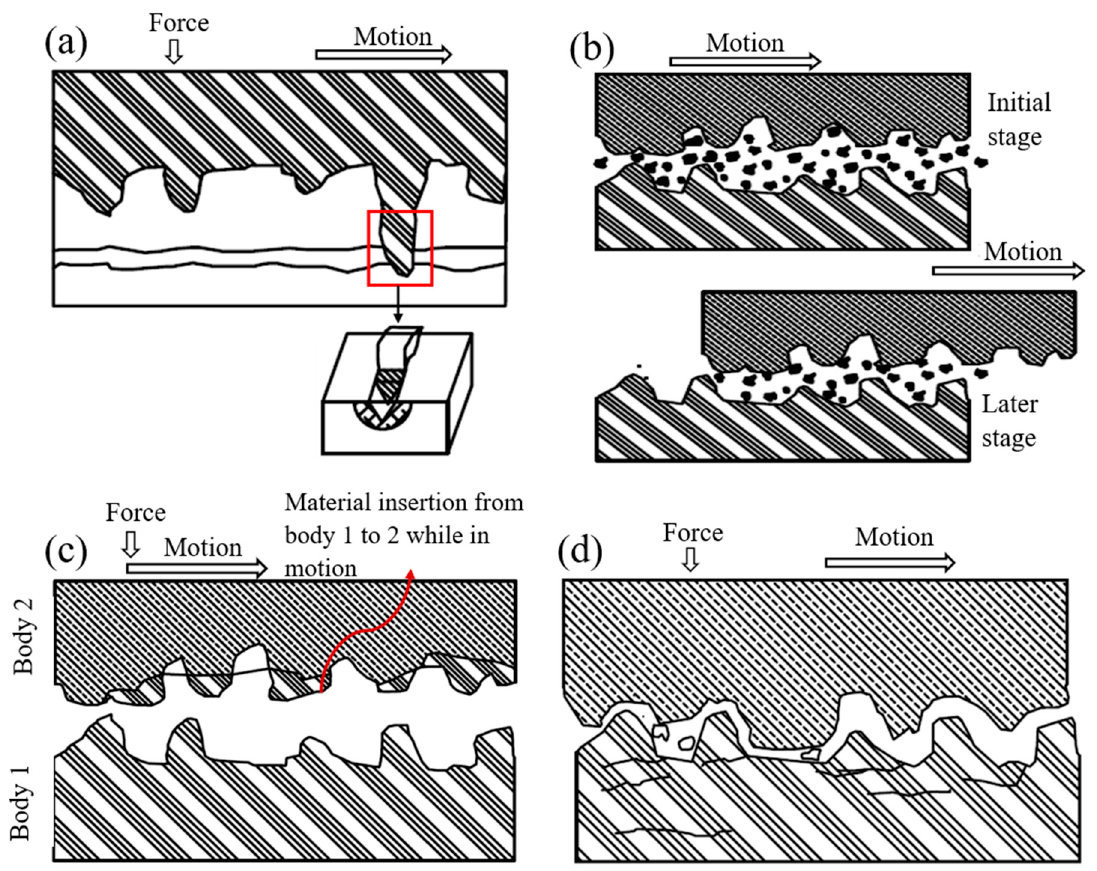
Figure 3. ( a ) Two-body abrasion, ( b ) three-body abrasion, ( c ) adhesive wear, ( d ) fatigue wear mecha- nism.